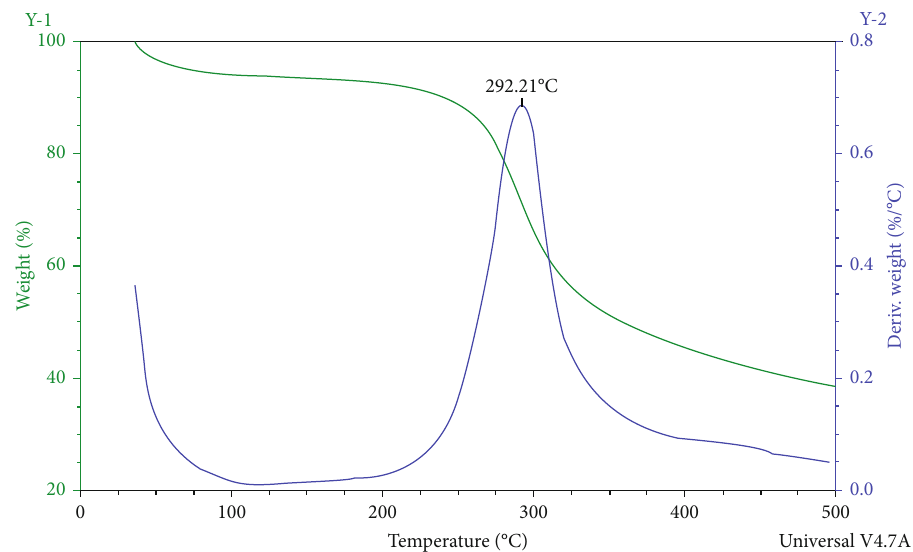
Figure 7: TGA Cu [A]-Qs QDs. The decomposition temperature of the compound (292.21 ° C) at a heating rate of 10 ° C/min in gas nitrogen fl ow.